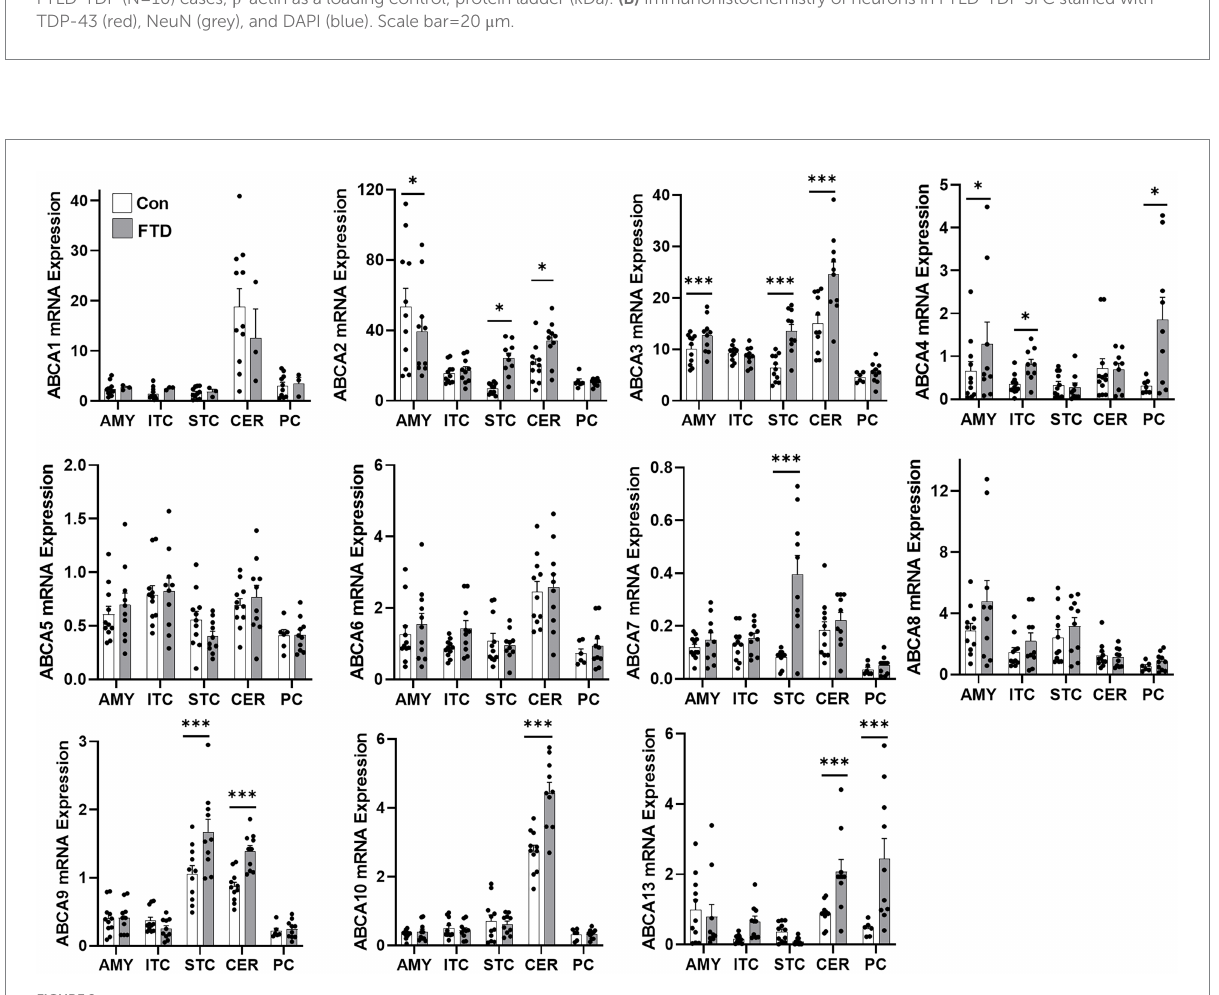
FIGURE 2 mRNA expression of ABCA transporters in FTLD-TDP and control brain. mRNA expression of ABCA transporters in amygdala (AMY), inferior temporal cortex (ITC), superior frontal cortex (SFC), cerebellum (CER) and parietal cortex (PC) in FTLD-TDP and control brain as measured by qPCR. Data represent mean and SE as error bars, * p < 0.05 and *** p <